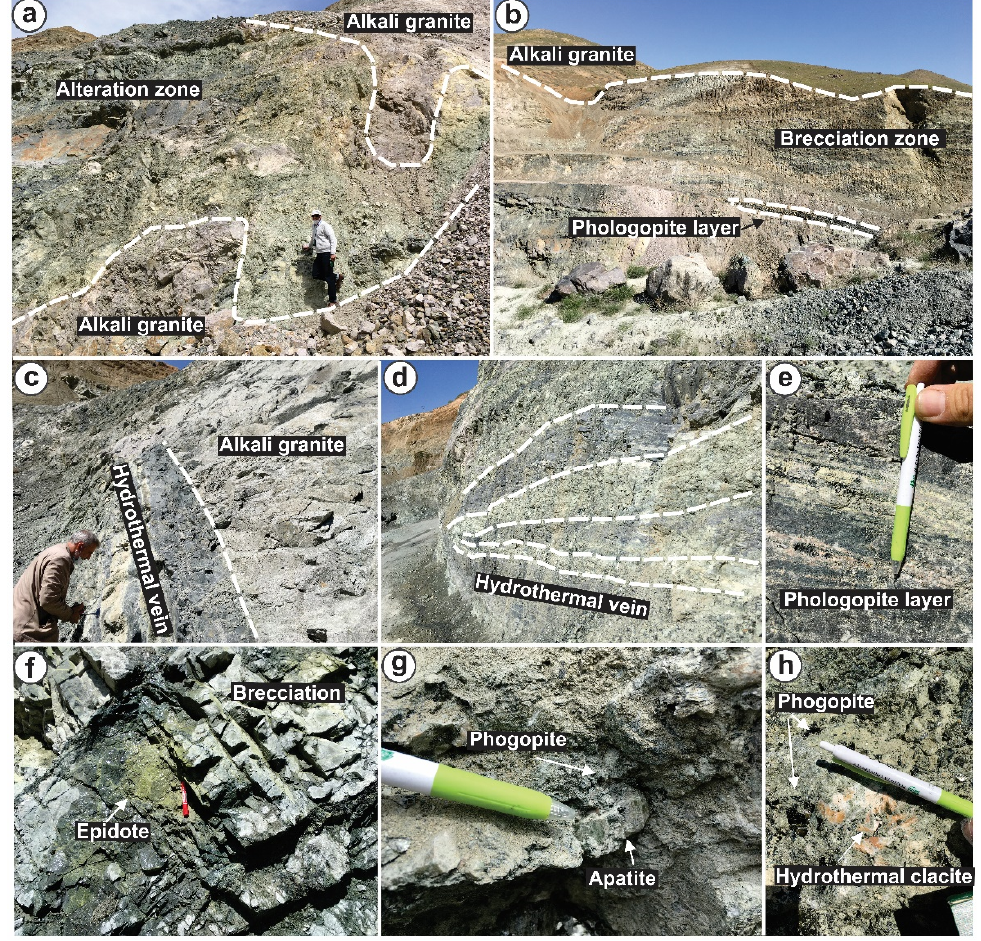
Figure 3. Photographs of field observation in the Ghareh Bagh mica mine. ( a , b ) A Ghareh Bagh mica mine pit. Photos show Ghareh Bagh mine located in alkali granite in the breccia zone with the high alteration. Mine is as layer trended in NW-SE. ( c , d ) Hydrothermal vein including the matrix of chlorite, biotite, actinolite, K-feldspar, calcite and quartz. ( e ) Phlogopite layer with NW-SE. ( f – h ) Coarse-grained minerals in parageneses of phlogopite in breccia are epidote, apatite and